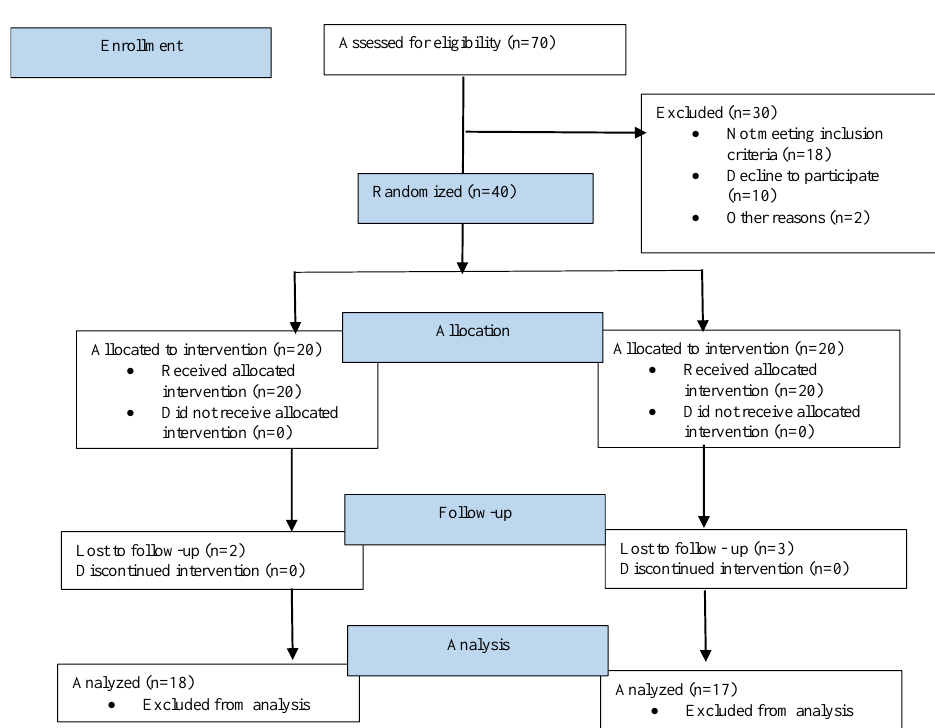
Figure 1. Flow diagram of study procedures.